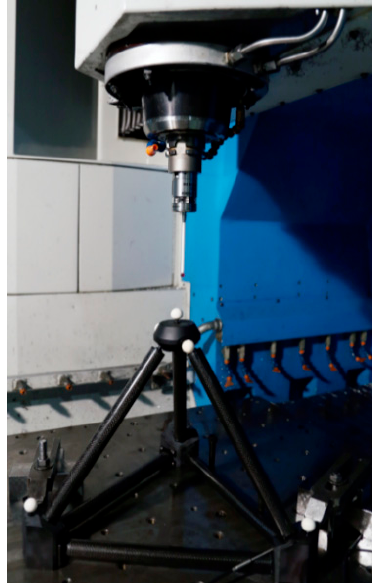
Figure 2. Monitoring machine tool performance.